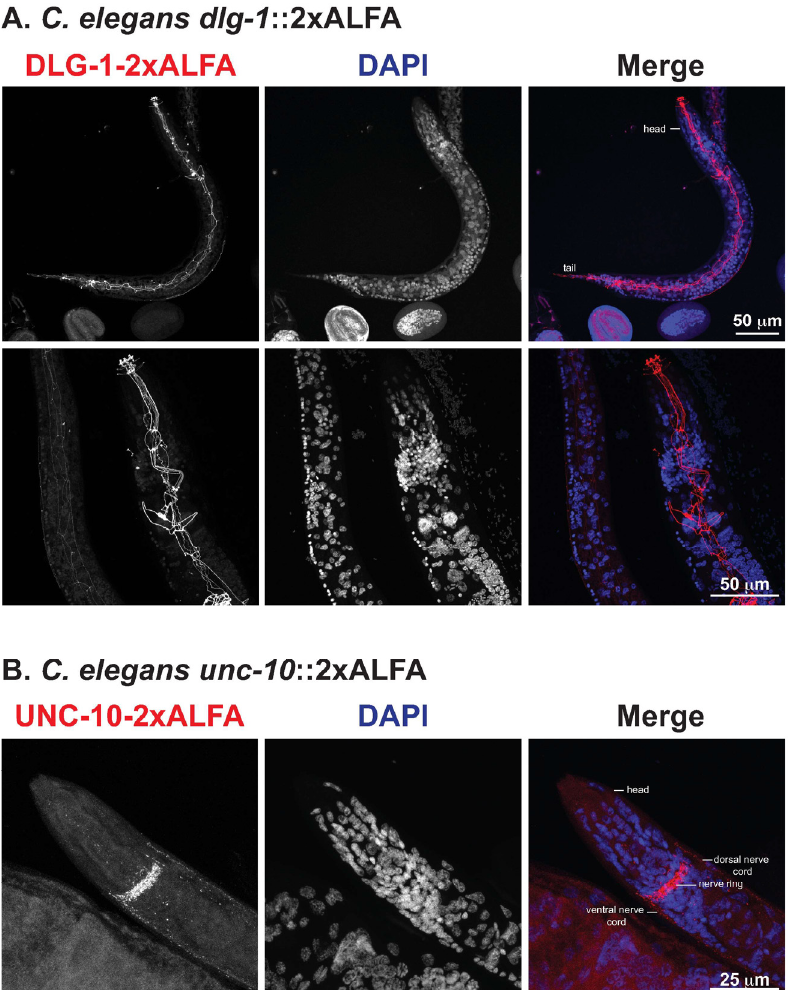
Figure 2. Spatial expression patterns of Ce dlg-1 ::2xALFA and Ce unc-10 ::2xALFA in adult worms. ( A , B ) Representative confocal fluorescent micrographs of the body and head of fixed C. elegans dlg-1(tu1782 [ dlg-1 ::2xALFA]) ( A ) and unc-10(tu1781 [ unc-10 ::2xALFA]) ( B ) animals. The worms were stained with anti-ALFA fluorescent nanobody. The merged images show the anti-ALFA signal in red and the nuclei in blue (DAPI staining). Images depict L4/adult